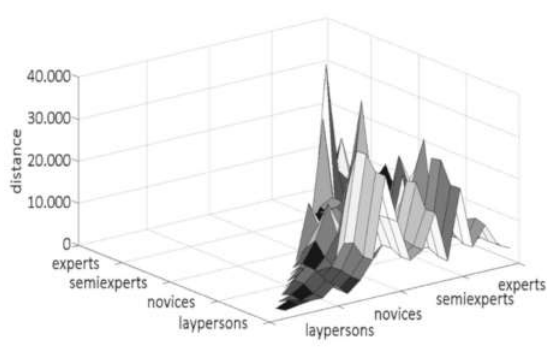
Table 8. Mean values of the distances grouped according to the divergence of the expertise level at the sculpture